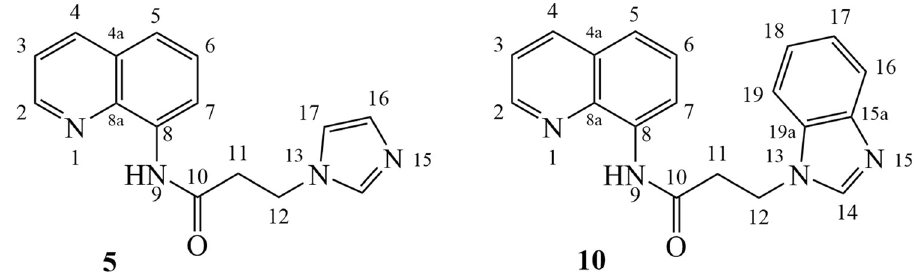
Figure 4. The number of atoms attributed to starting materials 5 and 10